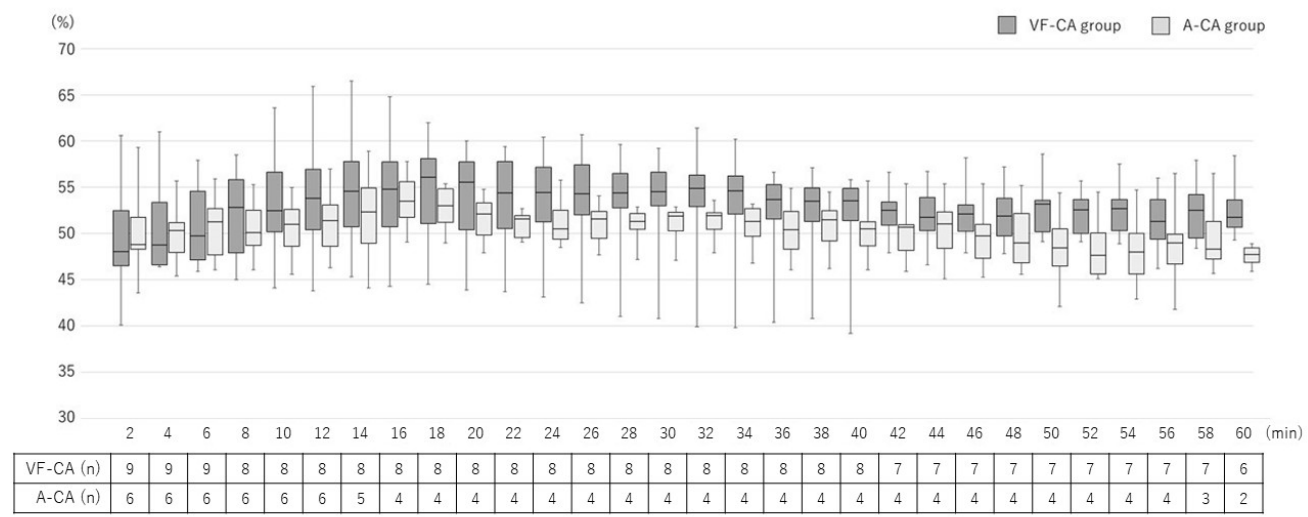
Figure 4. Changes in cerebral oxygen saturation (tissue oxygenation index; TOI) in the post-CPR phase. The increase in the TOI was similar between the groups ( p = 0.180). VF-CA, ventricular fibrillation cardiac arrest; A-CA, asphyxial cardiac arrest; TOI, tissue oxygenation index; CPR, cardiopulmonary resuscitation. Table 3. Outcomes of subjects in the ventricular fi brillation cardiac arrest (VF-CA) and asphyxial cardiac arrest (A-CA) groups.